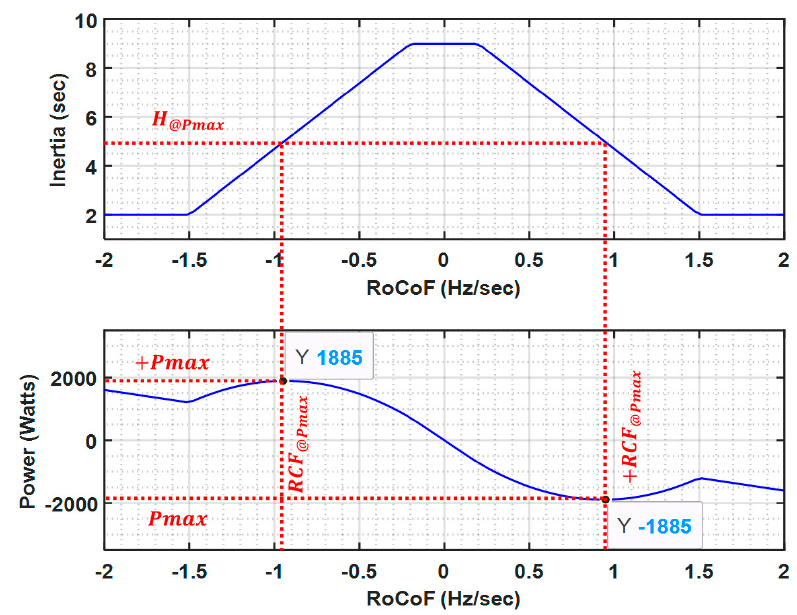
Figure 13. Power rating estimation of SC-PPS for SIR using the proposed Droop-inspired characteristics for dynamic inertia emulation as a function of RoCoF.